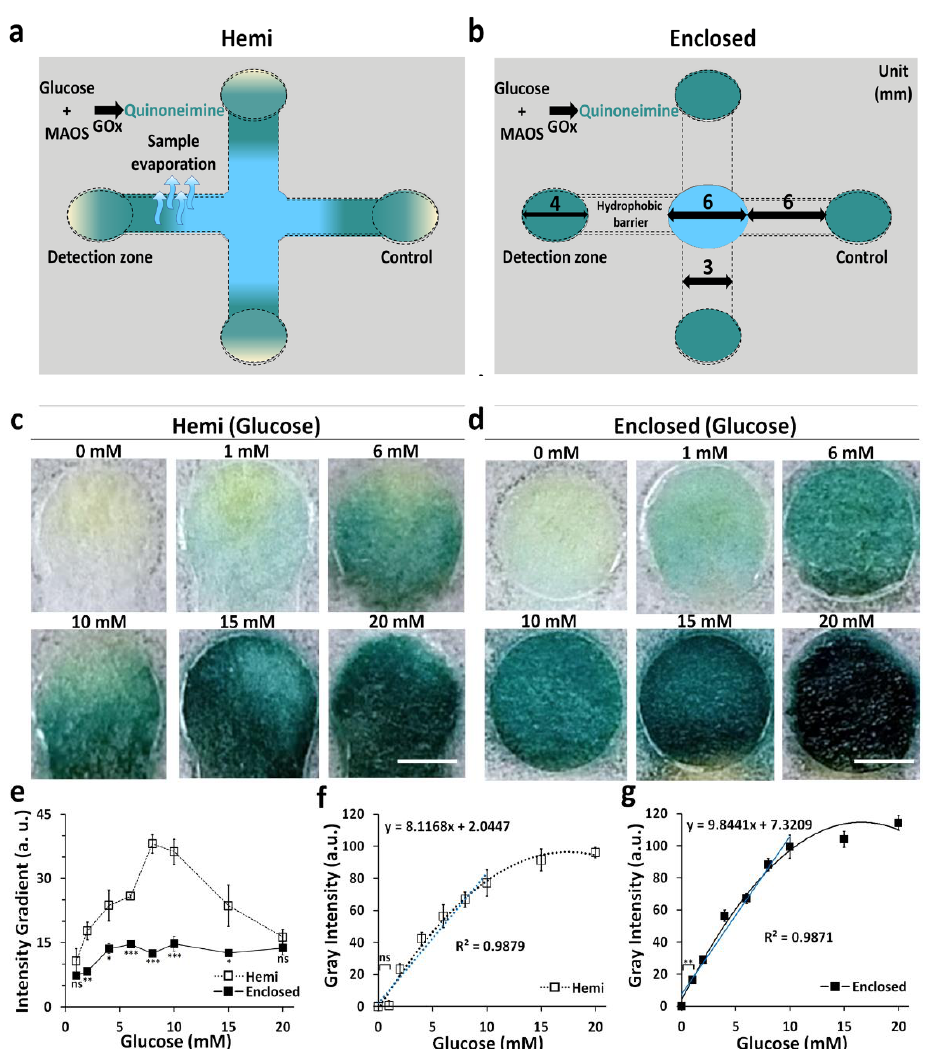
Figure 6. Comparison of sensitivity and uniformity of colorimetric detection of glucose in hemi channels and enclosed channels. ( a , b ) Schematics of the 3D-μPADs with hemi ( a ) and enclosed ( b ) channels for detection of glucose. ( c , d ) Representative images of the detection zones reacted with various glucose concentrations (0–20 mM) in hemi ( c ) and enclosed ( d ) channels (scale bar: 2 mm). ( e ) Color intensity gradient as a function of different concentrations of glucose in hemi channels and enclosed channels. n = 3, * p < 0.05, ** p < 0.01, *** p < 0.001. ( f , g ) Calibration curves of glucose were calculated from obtained images with various concentrations in hemi ( f ) and enclosed ( g ) channels. n = 3, ** p < 0.01.